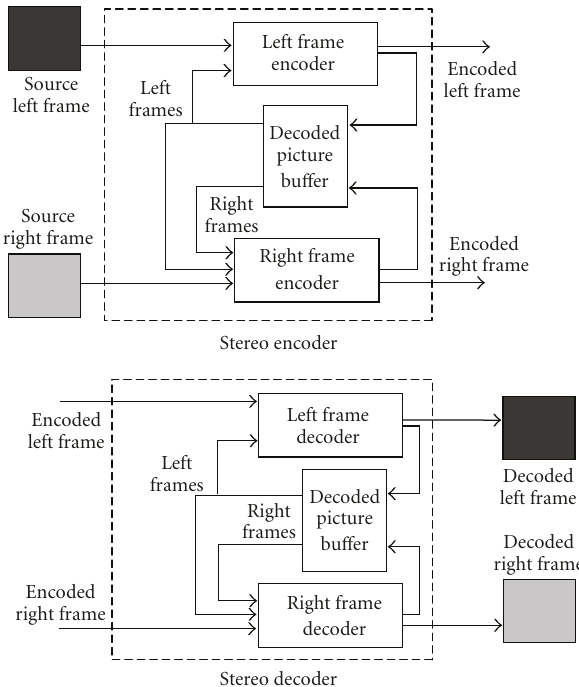
Figure 2: Stereoscopic encoder and decoder structure.